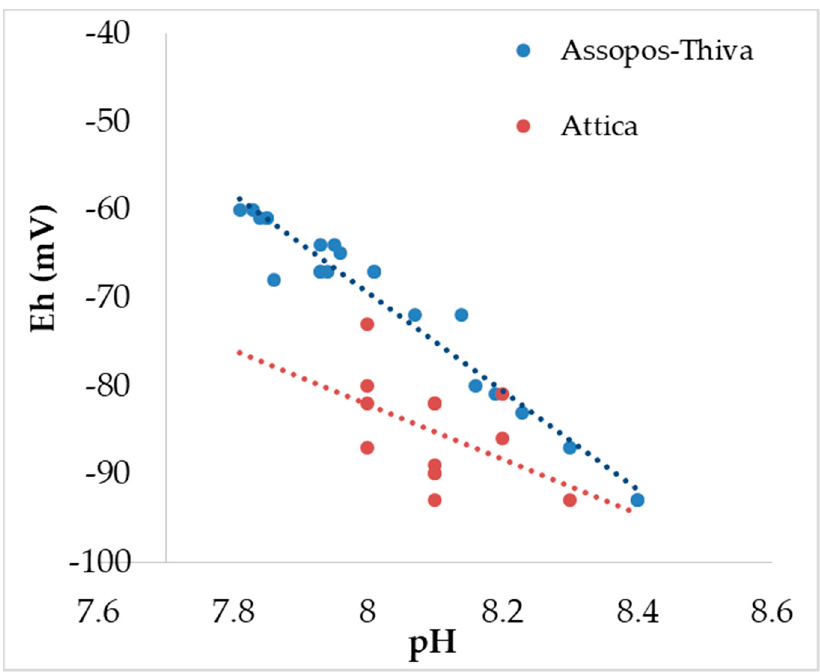
Figure 5. Plot of the Eh versus pH for soil samples from the Assopos-Thiva and Attica Neogene basins of Greece. Data from [22,33,51].